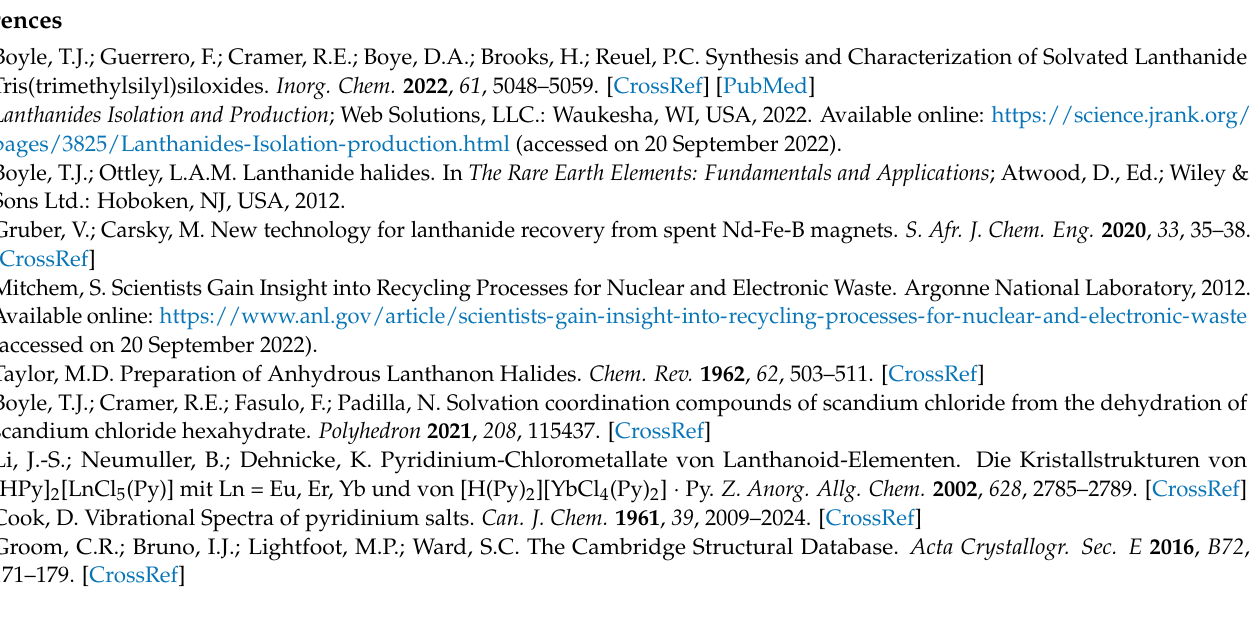
Table S6: Coulombic energies (Kcal/mol) for Nd-6 , Gd-6 , Tb-5 , and Lu-5 , Table S7: F-test results for Ln-5